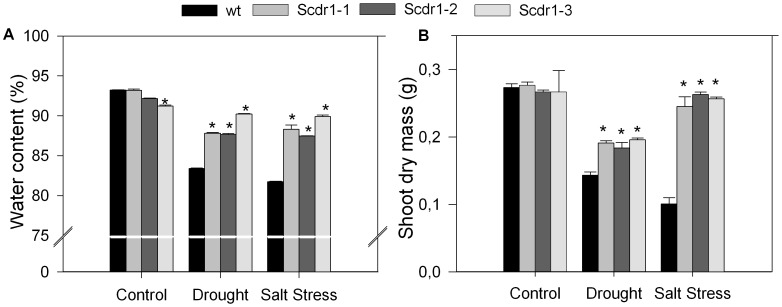
Water content and biomass in WT and Scdr1 transgenic plants.Thirty-day-old plants were exposed to 200 mM mannitol or 175 mM NaCl for 10 days and then allowed to recover for 3 days by watering with pure water. Control plants were irrigated with water only. The water content in leaves (A) and shoot dry matter (B) were evaluated. Bars represent the means of three independent experiments. Asterisk (*) indicates significant differences compared with WT plants in each treatment (P<0.001, n = 5).